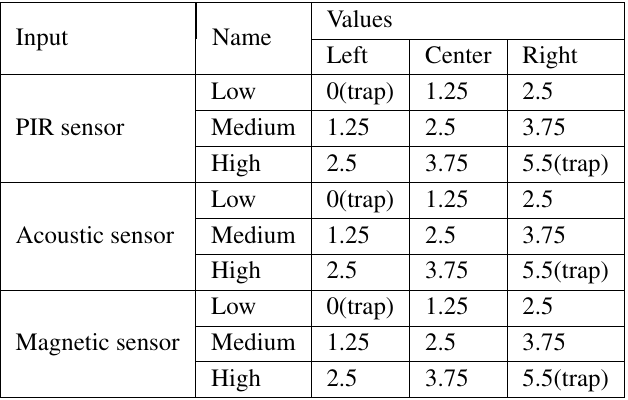
Table 1. Descriptionof the membership functions of each input.